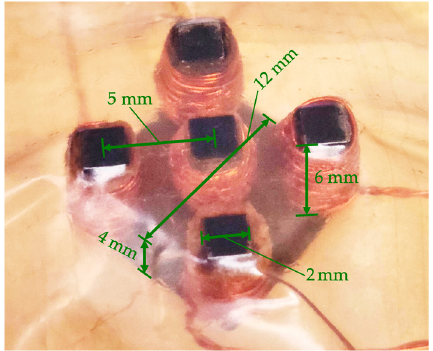
Figure 3. Photo of the transducer protected by the tape (bottom view). Table 2. Transducer